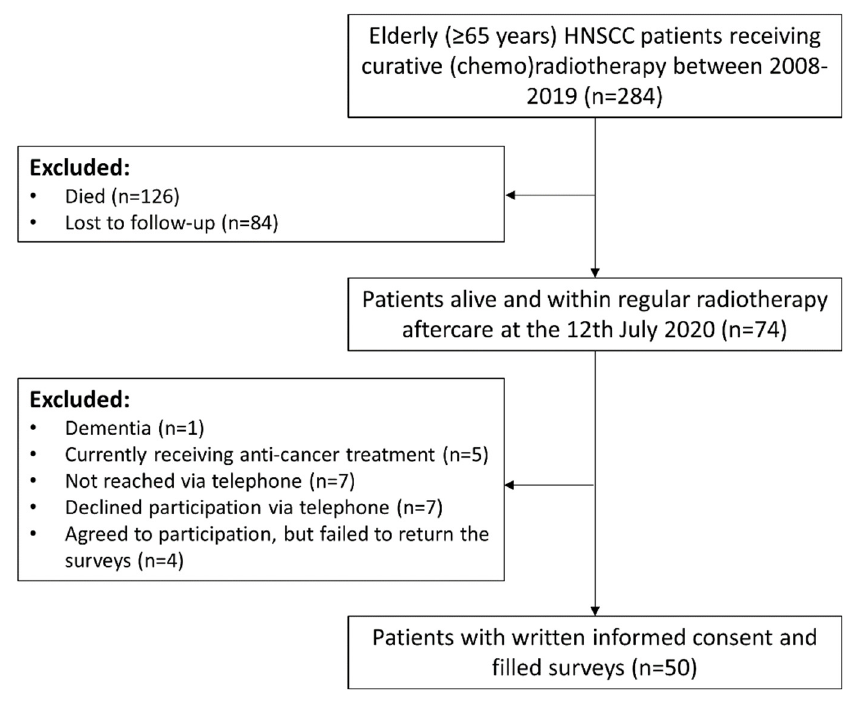
Figure 4. CONSORT flow diagram showing the enrollment of participants in the study.